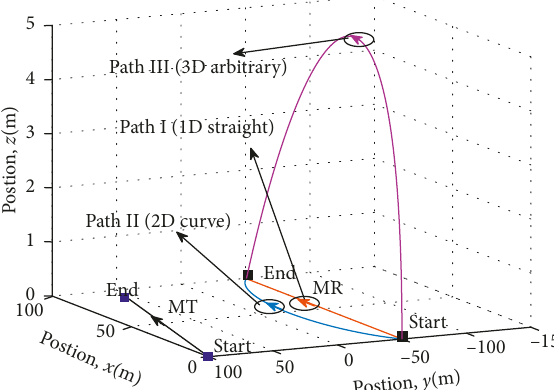
Figure 4: Three typical trajectories of the MR.